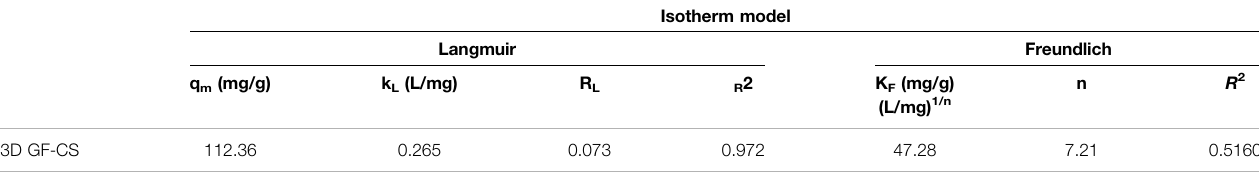
TABLE 4 | Langmuir and Freundlich isotherm model parameters for the adsorption of SMZ by 3D GF-CS.